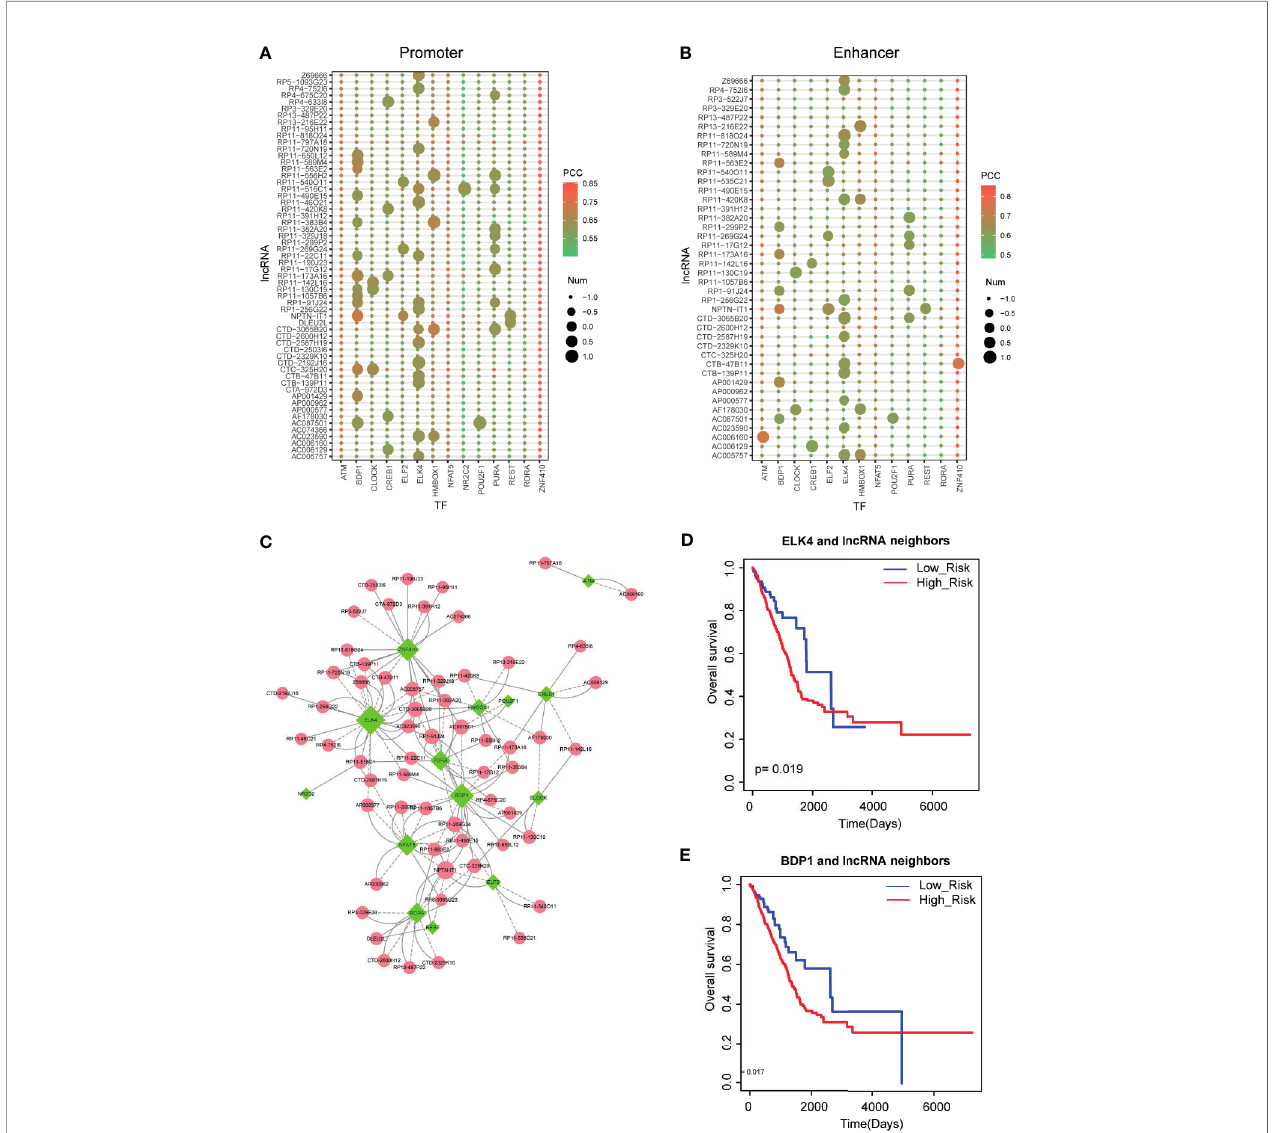
FIGURE 5 | Identi fi cation of lncRNA-TF positive feedback loops. (A, B) Motif scanning results of lncRNA promoter and enhancer regions. Heatmap represents the Pearson correlation coef fi cients between lncRNAs and TFs. Size represents the number of motifs in DNA regions. (C) Cytoscape visualization of lncRNA-TF positive feedback loops. (D, E) The prognostic effects of ELK4-lncRNA feedback pairs and BDP1-lncRNA feedback pairs in